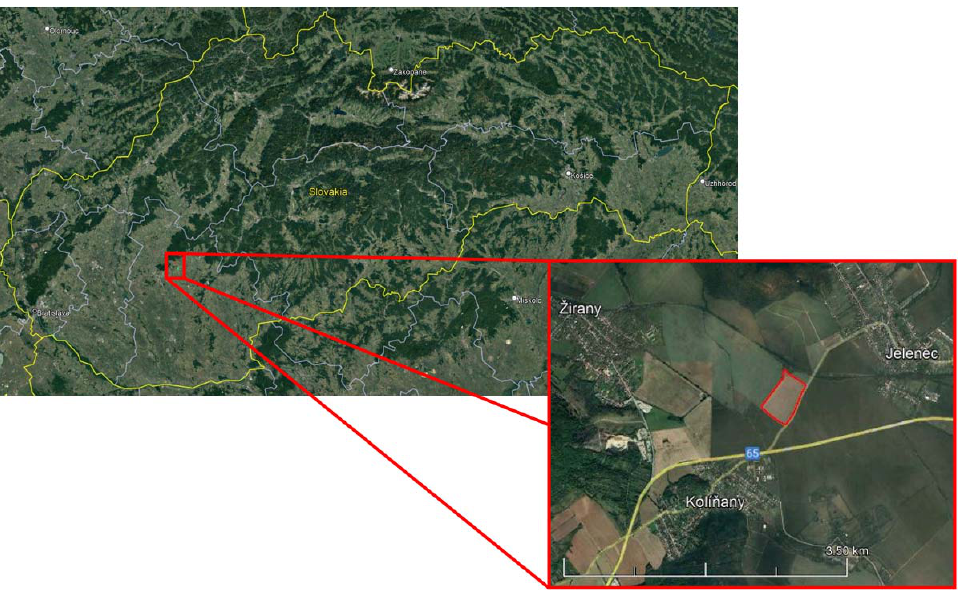
Figure 1. Study site of CTF experimental field “Pri Jeleneckej cete” in Kolí ň